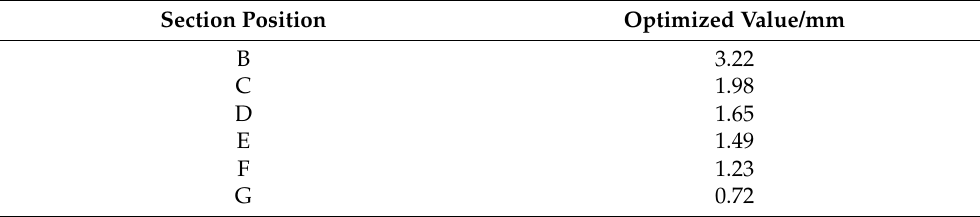
Table 4. Optimization results of the nose rail height value of each